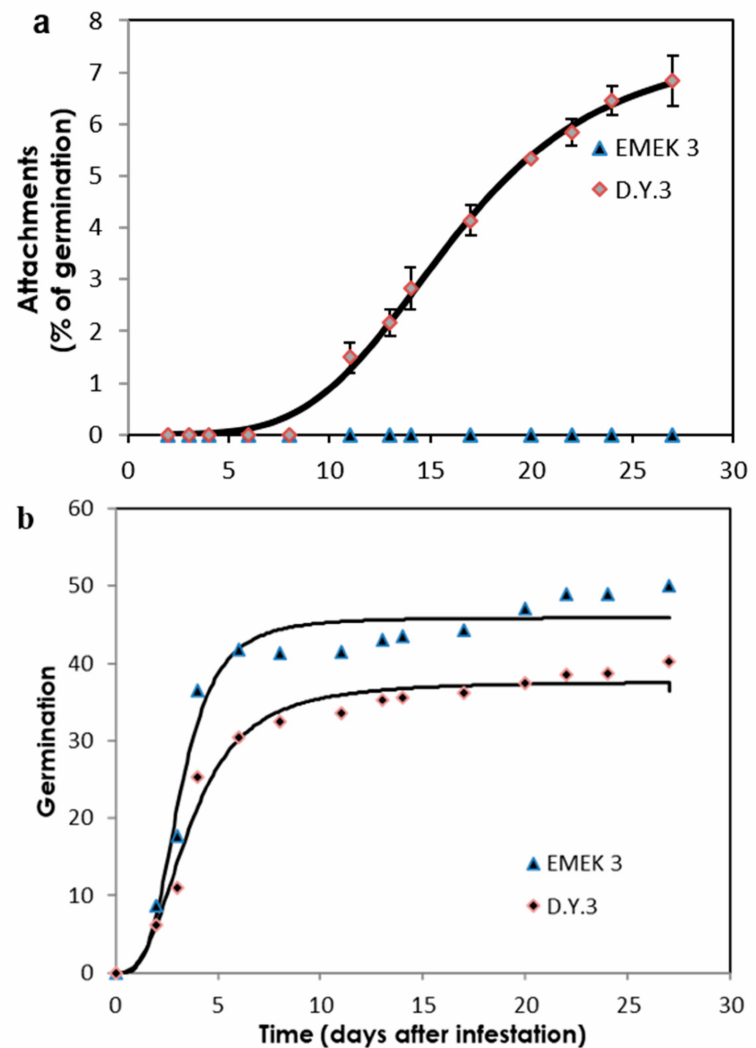
Figure 2. Parasitism dynamics of O. cumana on resistant (‘EMEK3’) and susceptible (‘D.Y.3’) sunflow- ers grown in a polyethylene bag system. Attachment (% of germinated seeds) ( a ) and germination ( b ) of O. cumana in the presence of resistant and susceptible sunflower